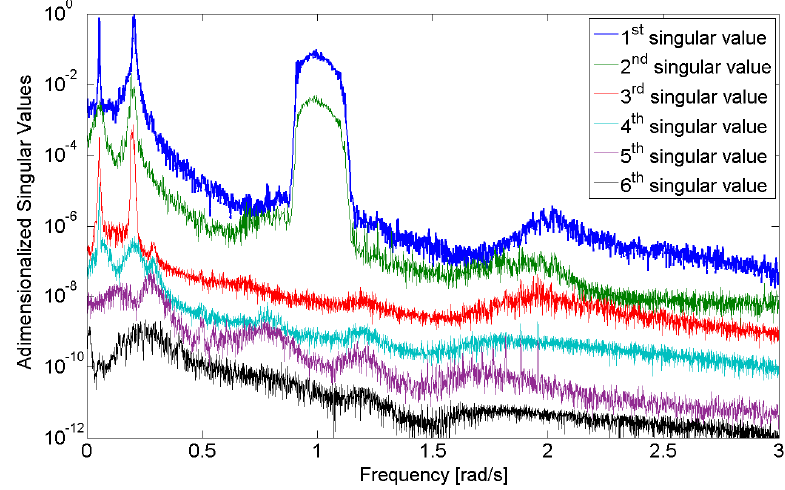
Figure 4. Singular value plot for the first combination of damping ratios (case 1) in non-resonant wave conditions.